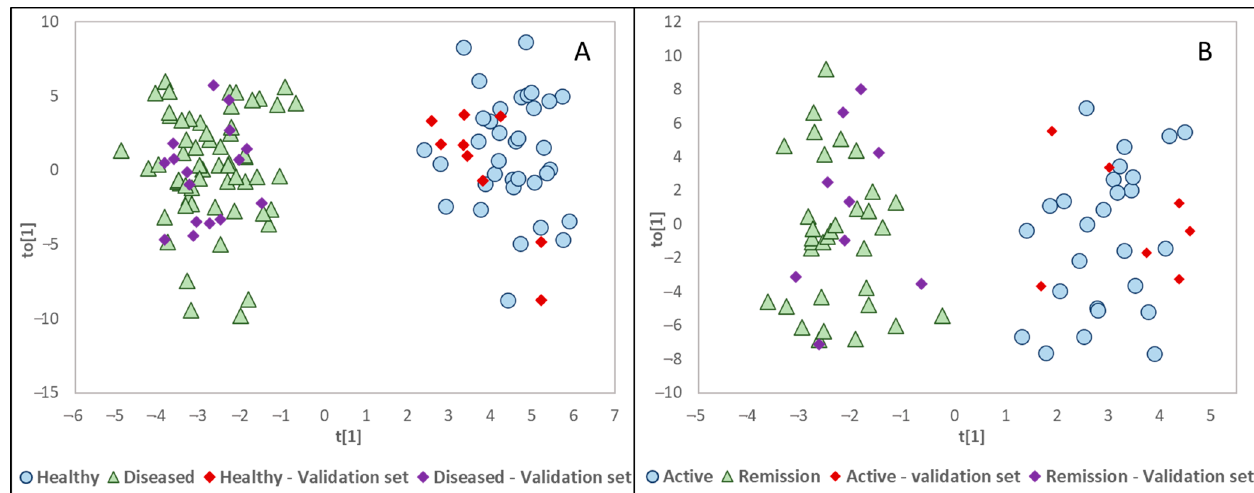
Figure 5. ( A ) Score ‐ plots of binary OPLS ‐ DA model using normalized data with respect to RIP in ‐ tensity and UV scaling to discriminate between urine of diseased and healthy IBD volunteers. ( B ) Score ‐ plots of binary OPLS ‐ DA model using normalized data with respect to RIP intensity and UV scaling to discriminate between urine of IBD diseased patients in active or remission